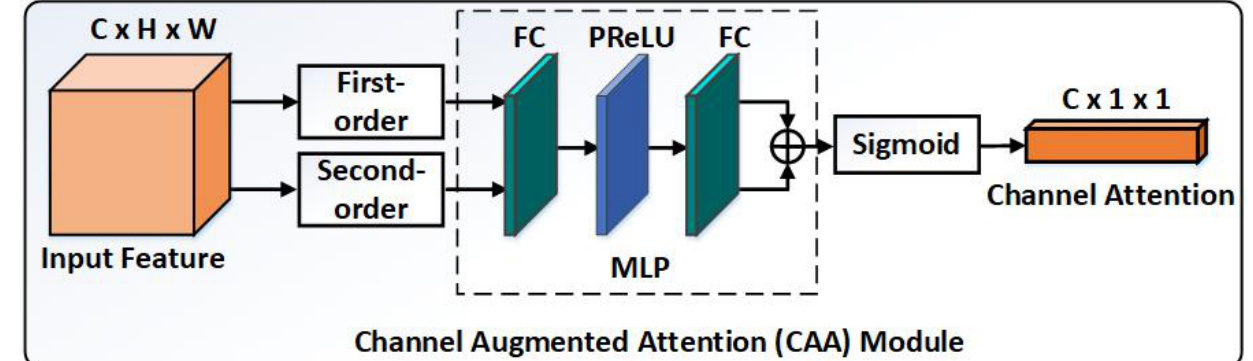
Figure 3. The overview of channel augmented attention module. ⊕ denotes the element-wise